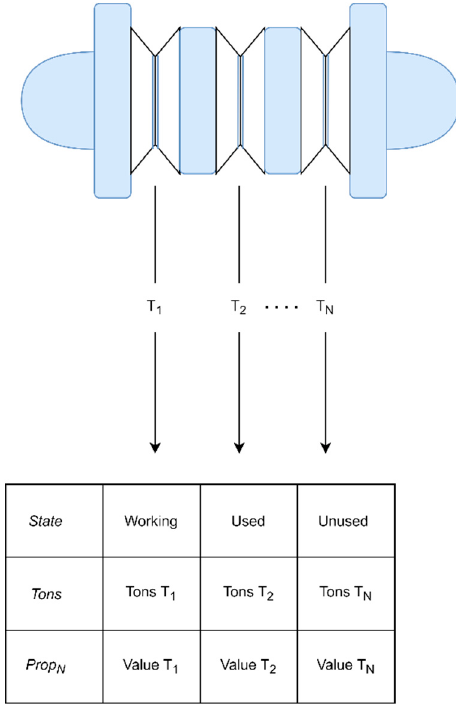
Figure 2. Schema of the main roll